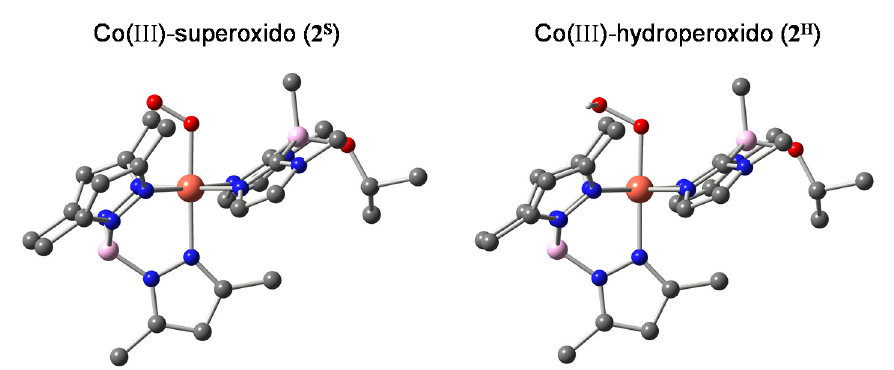
Figure 5. Optimized molecular structures of the superoxido ( left ) and hydroperoxido ( right ) com- plexes with Tp Me2,H and L OiPr .